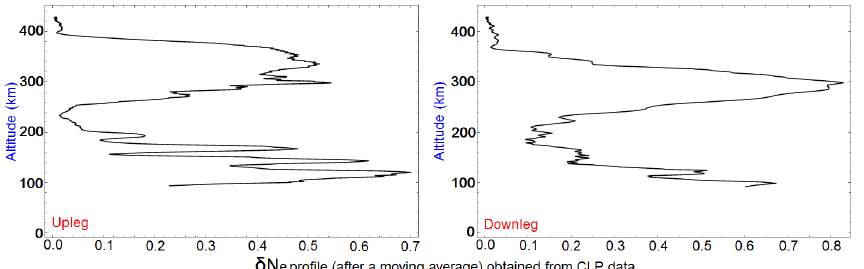
Figure 10. Irregularity fluctuation profile ( δN e ) obtained from the data collected by the Langmuir probe onboard the rocket. Irregular structures are represented by higher values of δN e